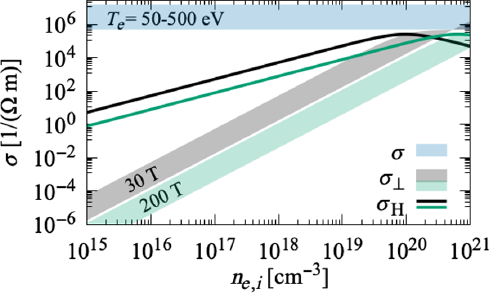
FIG. 10. The electrical conductivity tensor elements for ¯ Z ¼ 1 [Eq. (6)] as functions of plasma density in the electron temperature range 50 – 500 eV and with B θ ¼ 30 (black) or 200 T (green).